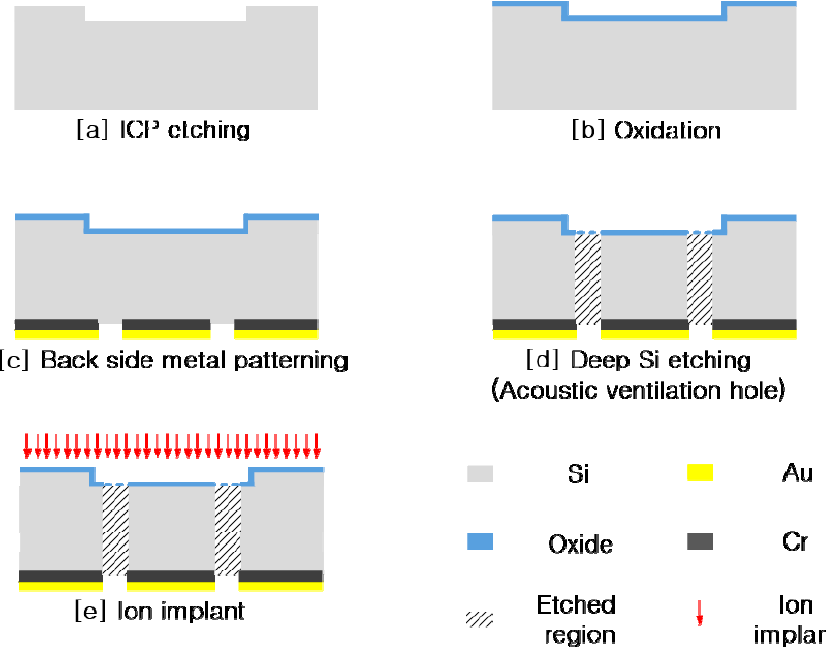
Figure 7. Fabrication process: FET embedded diaphragm substrate.